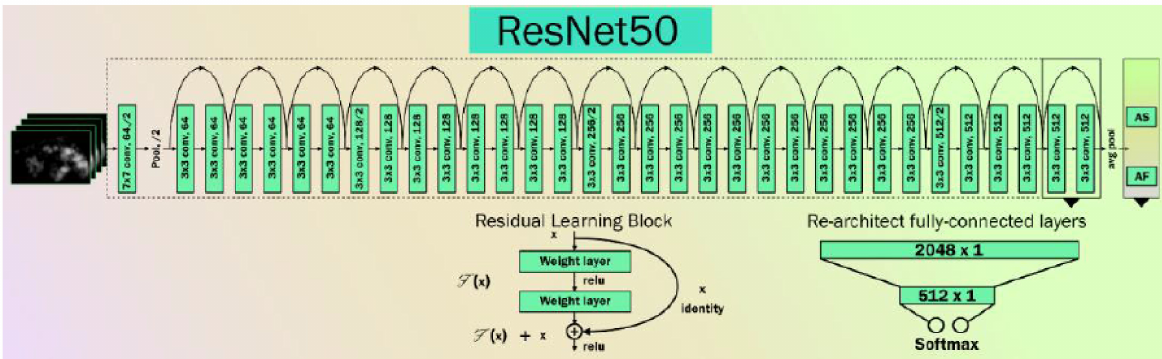
Figure A5. The general structure of Resnet50 architecture